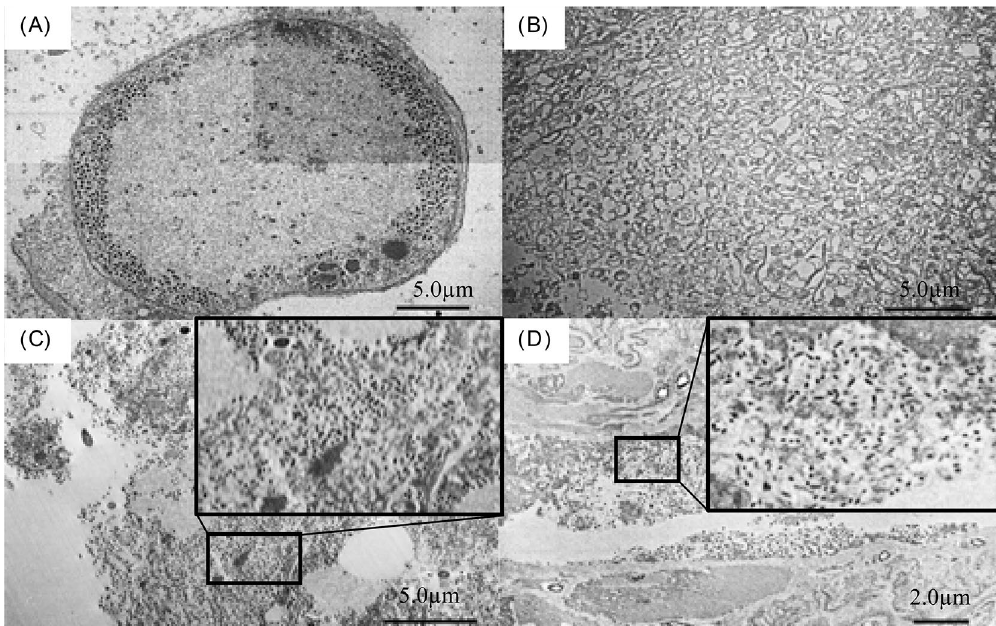
Figure 1. Electron micrographs of tissues of Palauan CRBs. ( A ) Japanese CRB adult was injected with the OrNV-X2B isolate as a positive control; fat body, ( B ) Japanese healthy untreated CRB adult; fat body, ( C ) Palauan field-collected CRB adult; fat body, ( D ) Palauan field-collected CRB adult; midgut. Magnifications were as follows. ( A ) ×4000, ( B ) ×2000, ( C ) ×2000, ( D ) ×3000. Black insets in ( C , D ) are higher-magnification images of virus particles (white